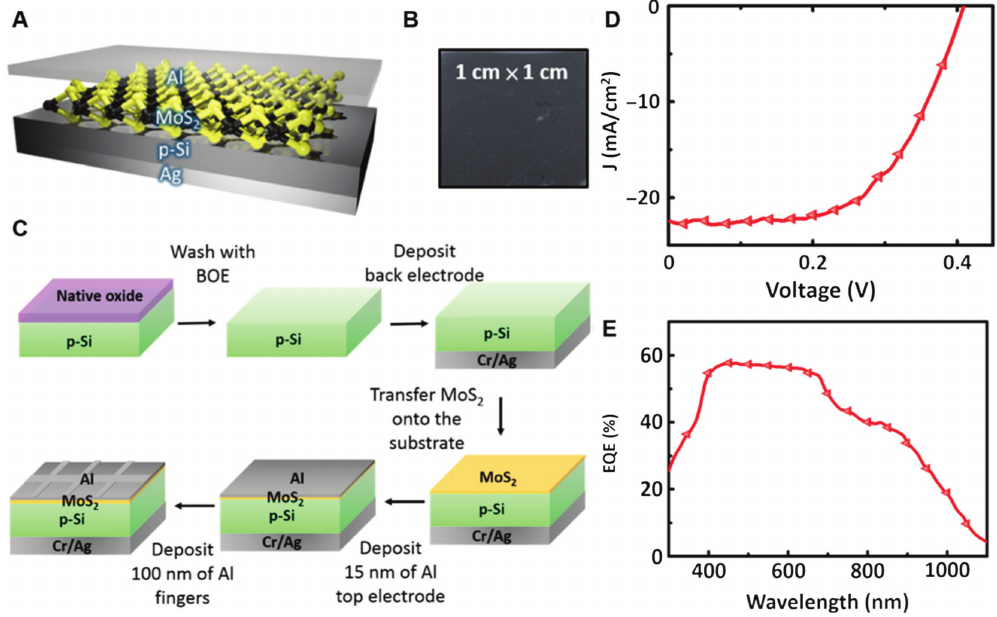
heterojunction solar cell. Figure 13: Monolayer MoS 2 (A) Schematic diagram for the device structure. (B) Photograph of monolayer MoS flow chart for the MoS /p-Si solar cell. (D) J - V characteristics and (E) EQE of the solar cell. Reprinted with permission of Ref. 2